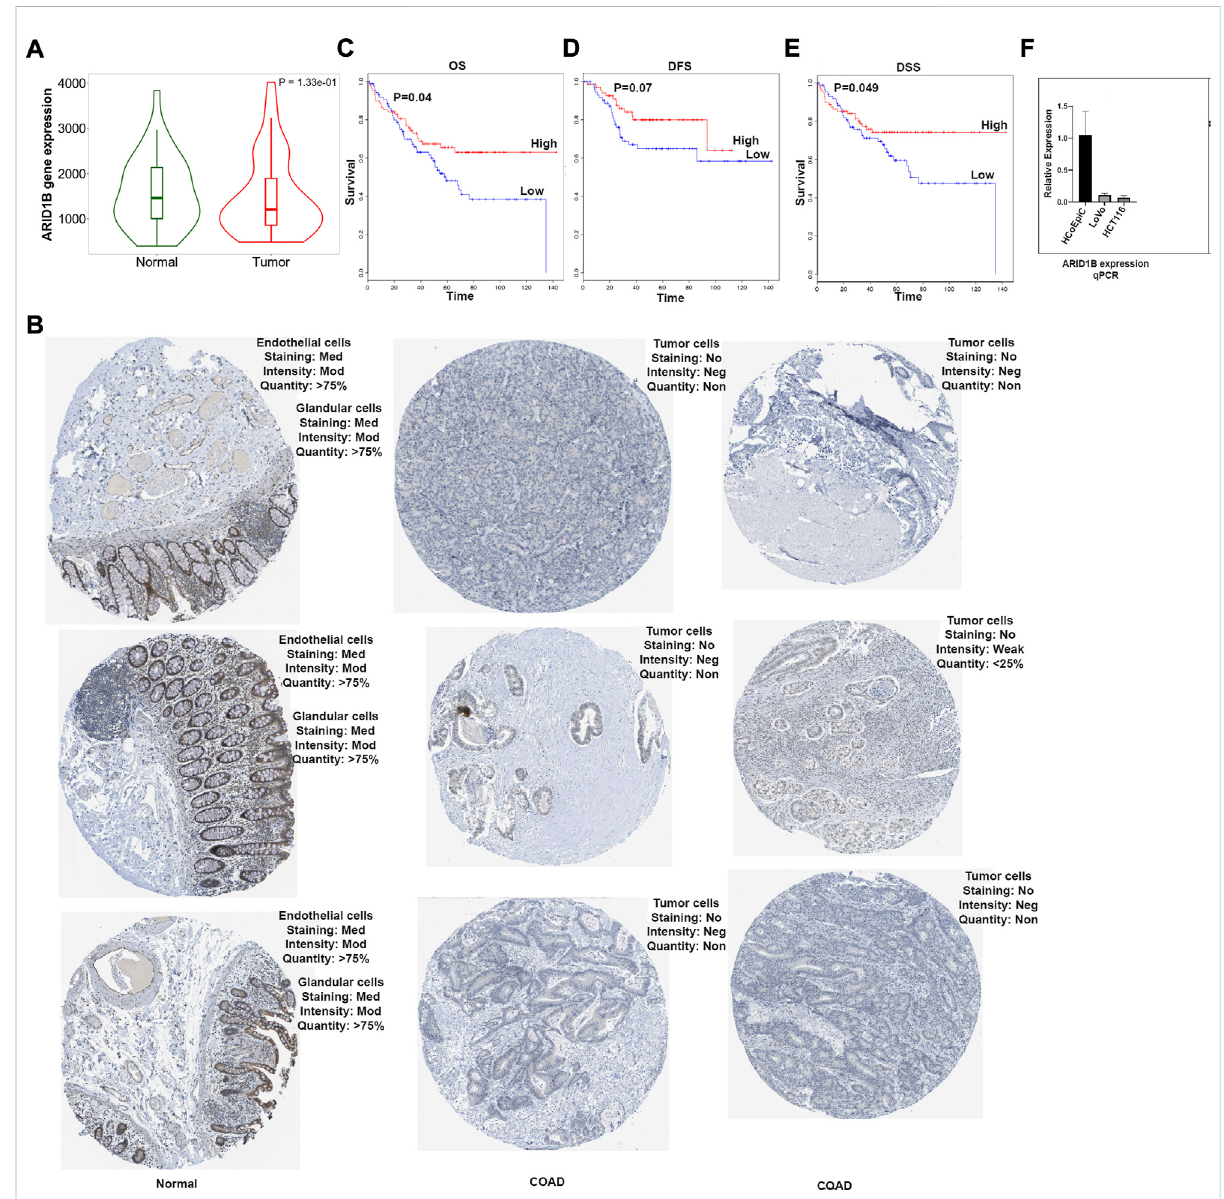
FIGURE 1 ARID1B mRNA analysis results. (A) ARID1B expression from TCGA, (B) ARID1B protein expression from HPA, (C – E) Kaplan Meir blot of Overall Survival, Disease Free Survival, and Disease Speci fi c Survival. (F) qPCR results, ARID1B is downregulated in cancer cell line compared to normal cell line. HPA, Human Protein Atlas; OS, overall survival; DFS, disease-free survival, DSS; disease-speci fi c survival; Med, Medium; Mod, Moderate; Neg, Negative; Non,